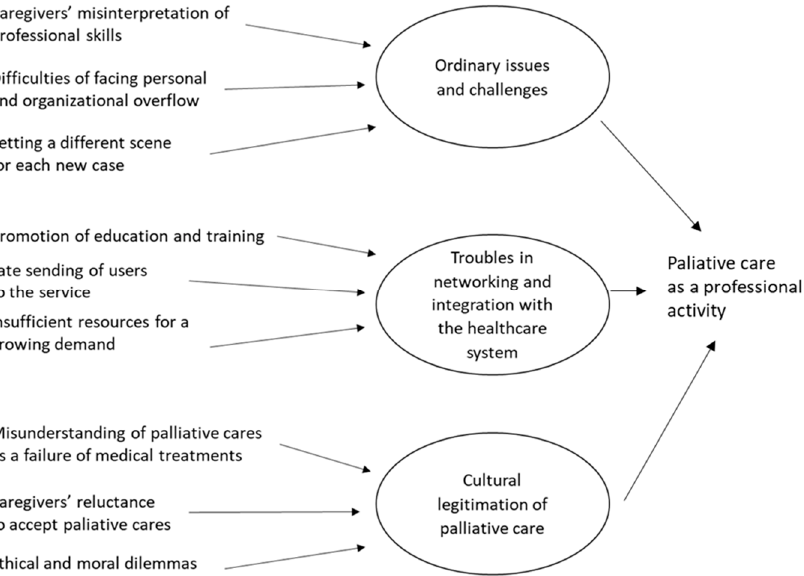
Figure 2. The structure of data collected from the focus groups with professionals as emerged in our analysis.